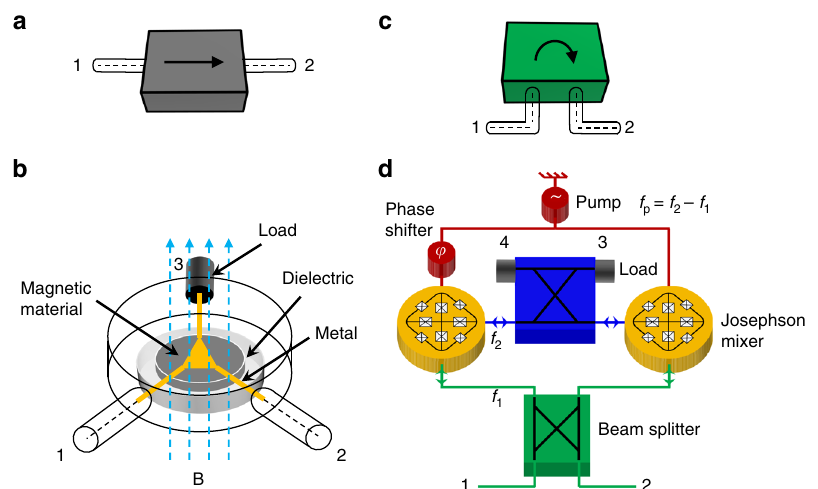
Fig. 1 Magnetic-based isolator versus the MPIJIS. A microwave isolator, whose circuit symbol is shown in a , is a unidirectional, two-port microwave device. It transmits signals from port 1 to 2 (as indicated by the arrow) and blocks signals propagating in the opposite direction. To break the transmission- coef fi cient symmetry between source (input) and detector (output), commercial isolators rely on magneto-optical effects, which require magnetic materials and strong magnets. One common realization of such isolators is a three-port circulator in which one of its ports (i.e., 3) is terminated by a 50 Ω load as shown in b . In this example, signals entering port 1 are directed towards port 2, whereas signals entering port 2 are dissipated in the matched load attached to the internal port 3. c A circuit symbol for the Josephson-based isolator realized and measured in this work, which is based on a different reciprocity-breaking mechanism. In this device, schematically shown in d , two active Josephson mixers are coupled via beam-splitters and driven by a microwave pump source. Unidirectional transmission from port 1 to 2 is generated by constructive and destructive wave interference between different paths in the device. The interference pattern is controlled by the phase difference φ = − π /2 between the pumps feeding the two mixing stages. Signals propagating from port 2 to 1 are dissipated in the matched loads connected to the internal ports 3 and 4